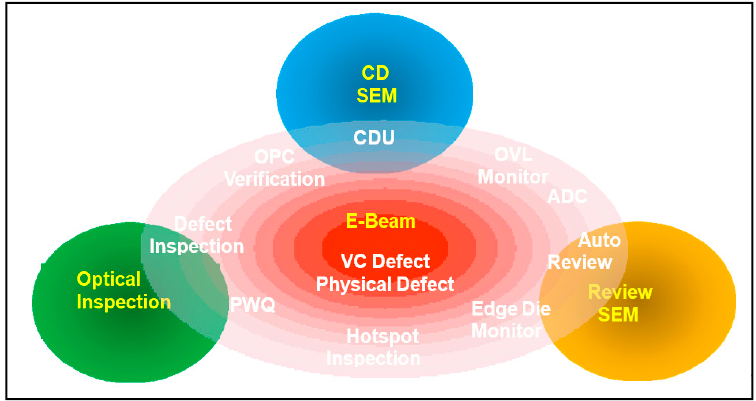
Figure 13. E-Beam technology and its allied areas.